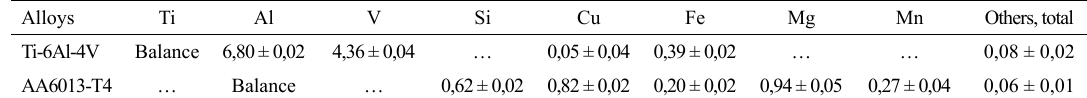
Table 1. Chemical composition of Ti-6Al-4V and AA6013-T4 (%). Alloys